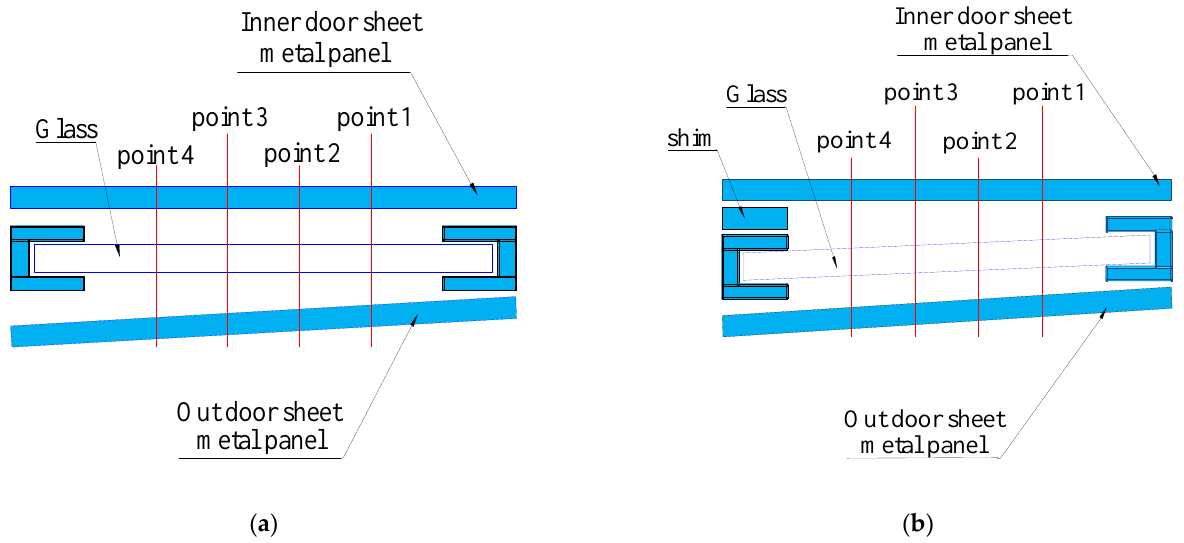
Figure 16. Window structure diagram before and after adding gasket. ( a ) Diagram of window without shim; ( b ) Diagram of window with shim.